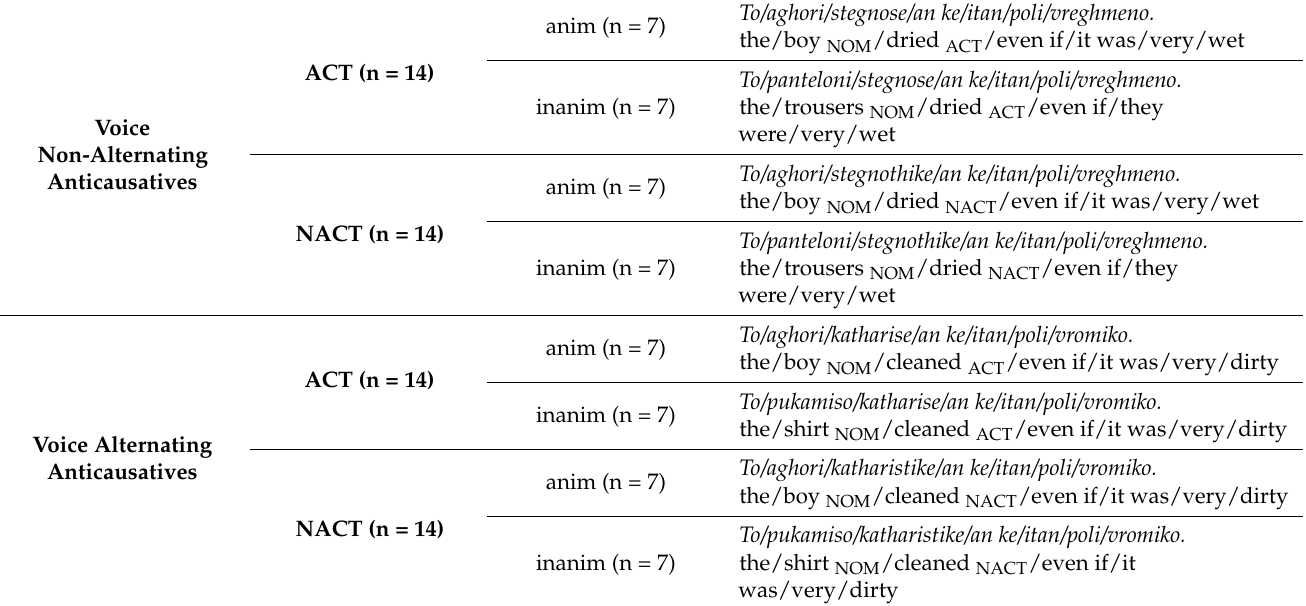
Table 3. Example sentences of the SPR task 7